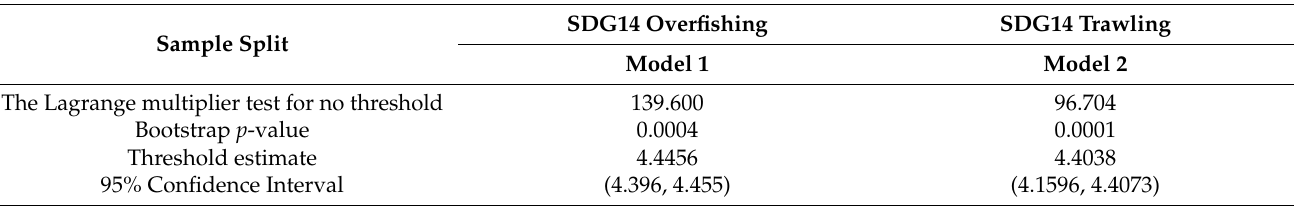
Table 6. Threshold estimates of using different threshold variables after adding country control variables (GDP growth rate and poverty